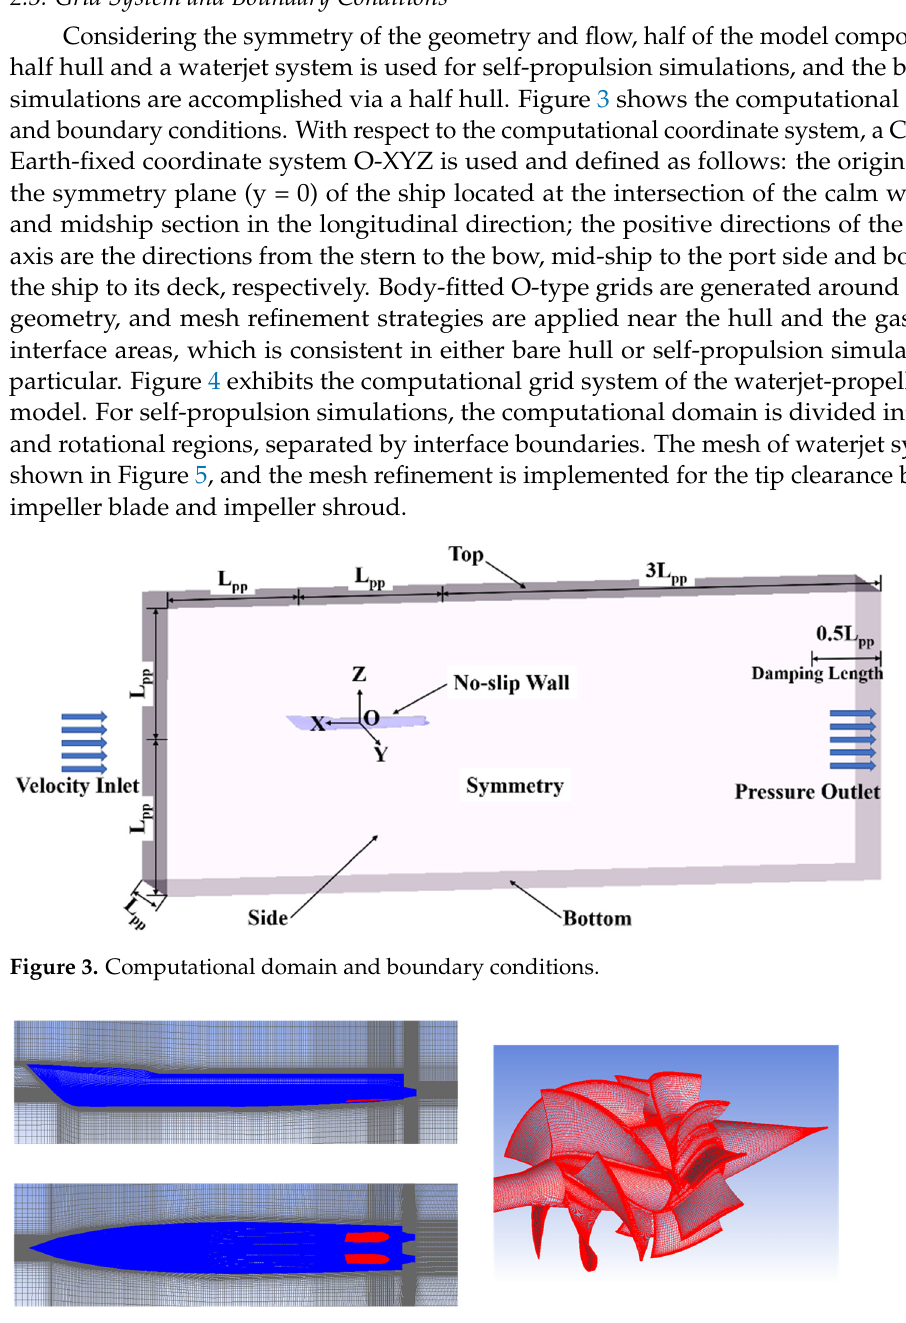
Figure 5. The mesh of waterjet system. 2.4. Multiple Reference Frame Model and Sliding Mesh Model The multiple reference frame (MRF) model is a steady-state approximation, in which every grid zone can be assigned different rotational and translational speeds. The local reference frame transformation is executed at the interfaces between zones, so that the flow information can be transferred between the adjacent zones. Additionally, an addi- tional correction term for the local reference frame transformation is applied on all sur- faces (including the interfaces and wall surfaces) where rotation or translation is mod- elled. The MRF approach cannot account for the relative motion of a moving zone with respect to adjacent zones, and the mesh remains unchanged during calculations. There- fore, if strong rotor-stator interaction is considered, it is more appropriate to use the tran- sient sliding mesh model instead of the steady MRF model. However, the flow field com- puted by the steady MRF model can be used as an initial condition for a transient sliding mesh model. In the sliding mesh model, the multiple zones are connected by non-conformal inter- faces. The non-conformal interface is updated with the grid motion. A particular concern